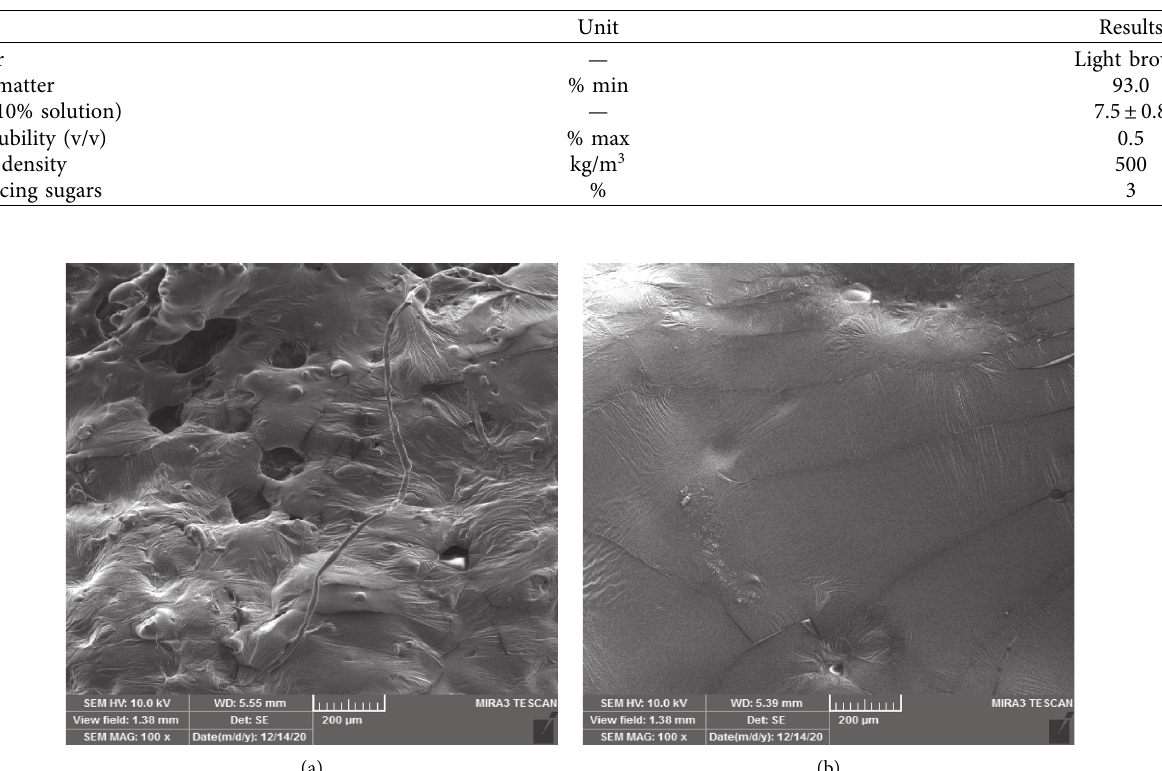
Table 3: Physical specifications of calcium lignosulfonate.